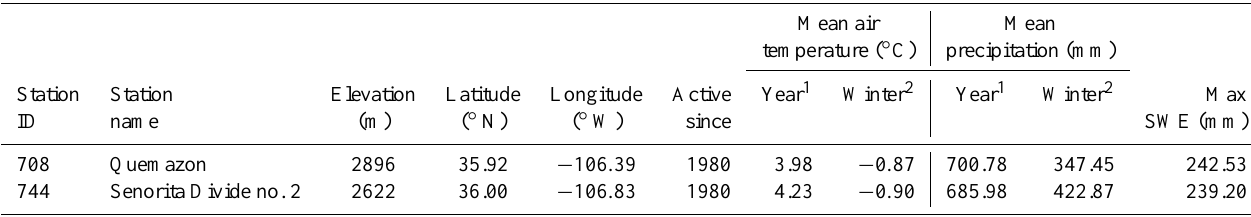
Table 2. Site and meteorological information for the SNOTEL Quemazon and Señorita Divide no. 2 stations located at high elevations in the upper part of the